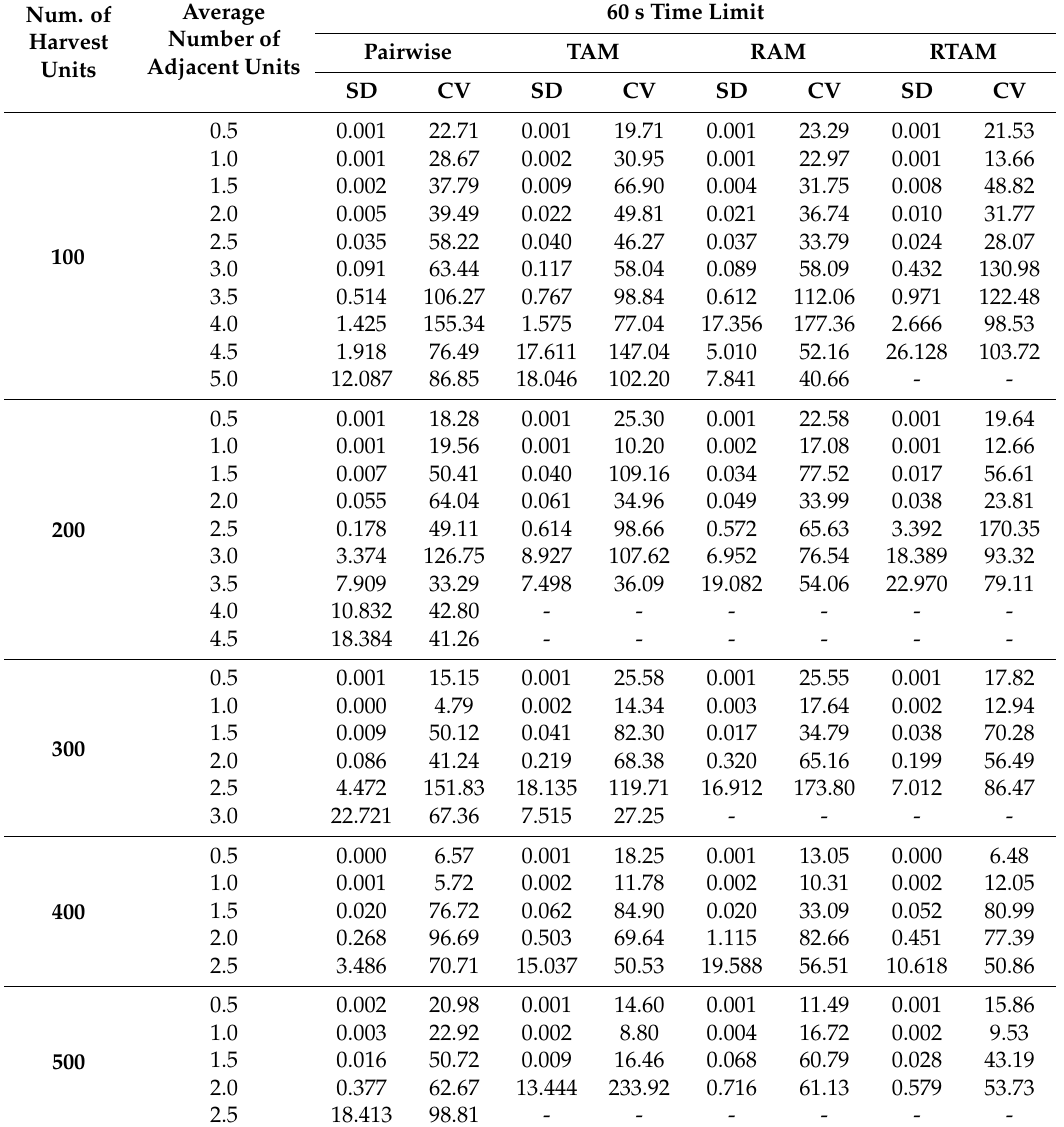
Table 11. Resulting standard deviation (SD) and coefficient of variation (CV) of solving time for 60 s time limit. Num.